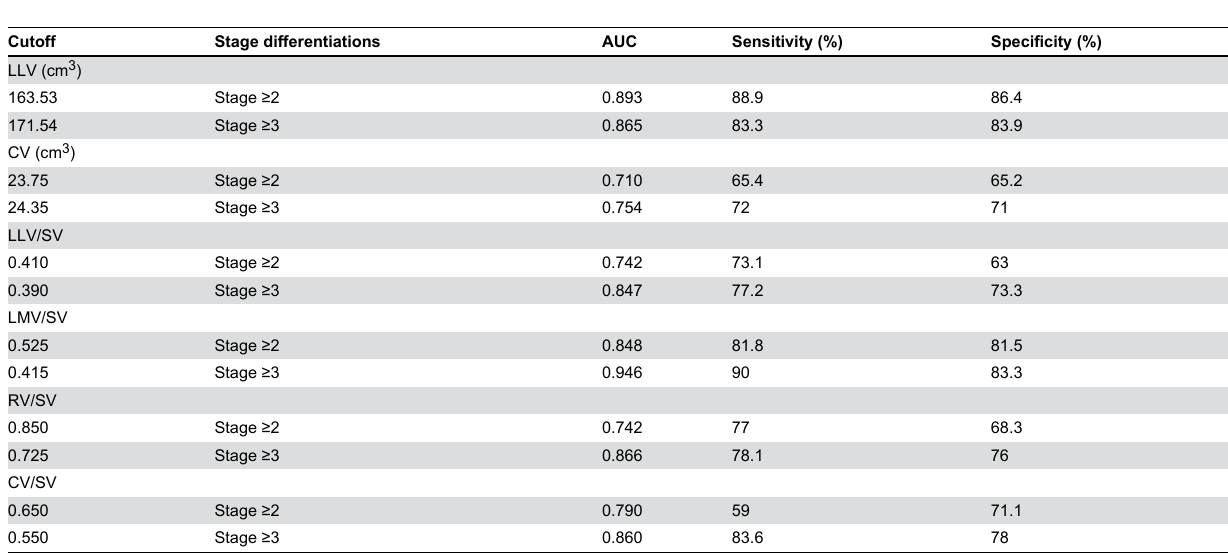
Table 4. Receiver-operating characteristic analysis of liver lobe volume parameters for classifying liver fibrosis stage ≥2 and